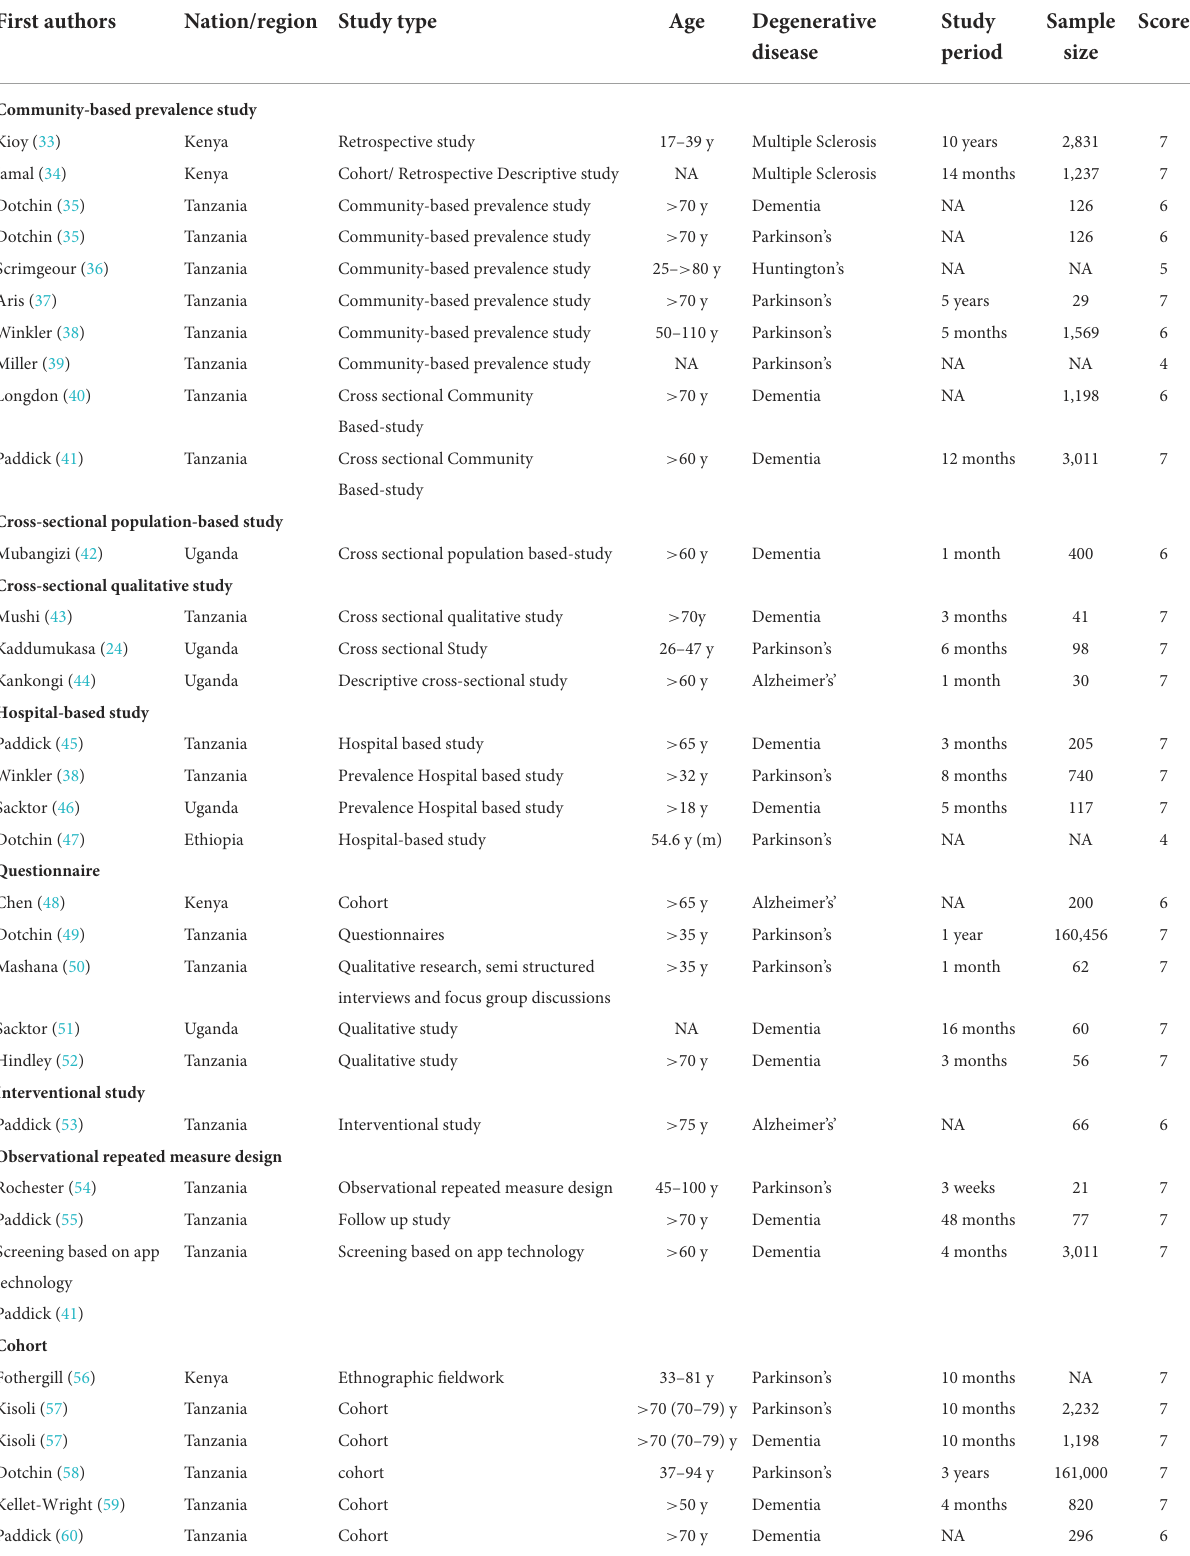
TABLE 1 Overall characteristics of the included